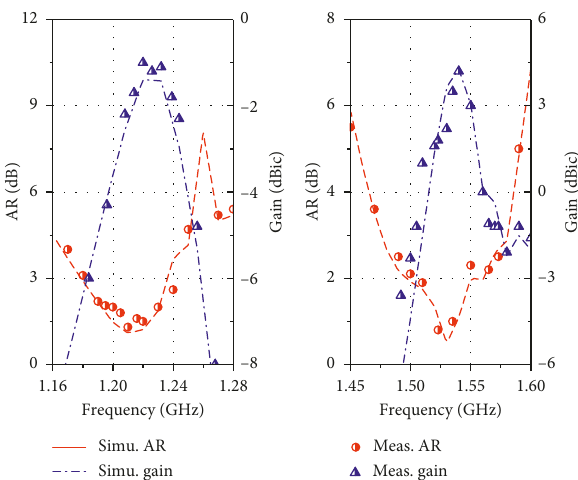
Figure 15: Measured and simulated gain and AR of the fabricated antenna.